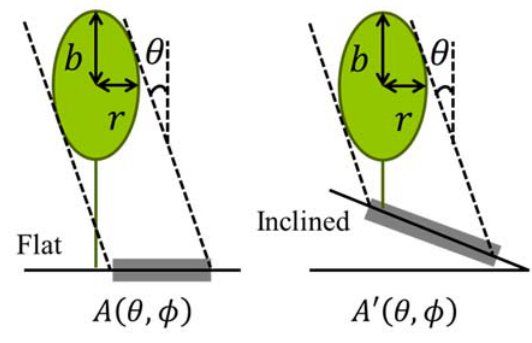
Figure 3. Change in the crown area projected to the ground caused by the terrain effect. θ is the solar zenith angle, b is half the height of the crown, and r is the crown radius.